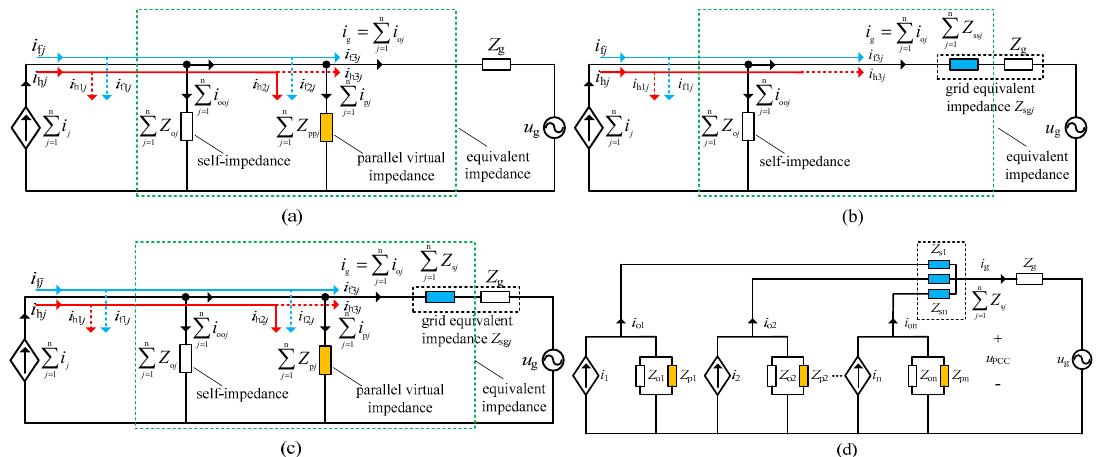
Figure 3. Equivalent schematic diagram. ( a ) Parallel virtual impedance; ( b ) series virtual impedance; ( c ) parallel-series virtual impedances; ( d ) equivalent output impedance model.